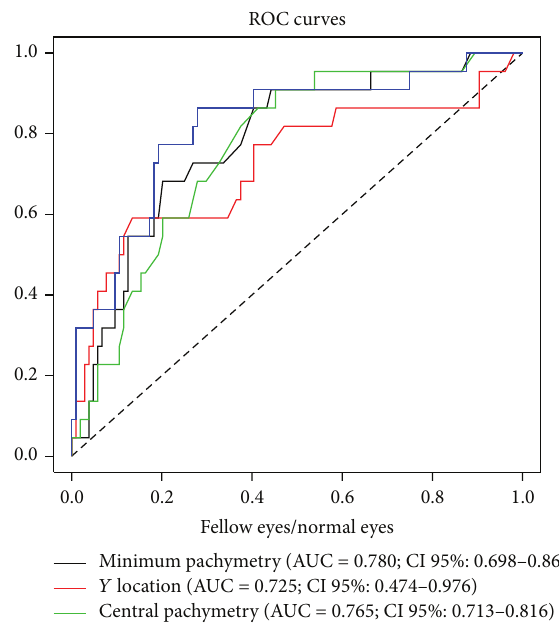
Figure 2: ROC curves and AUC for the three variables showing significant differences between normal and fellow eyes and for the model combining these three variables.